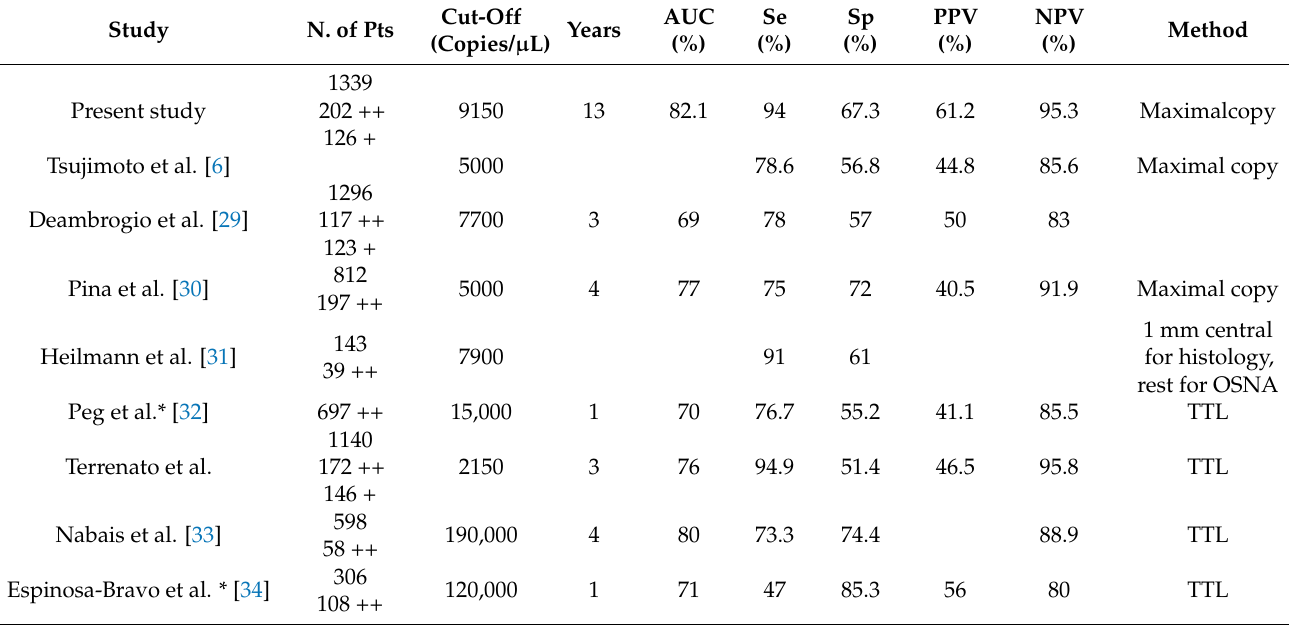
Table 3. Comparison of our OSNA cut-off with other alternatives from